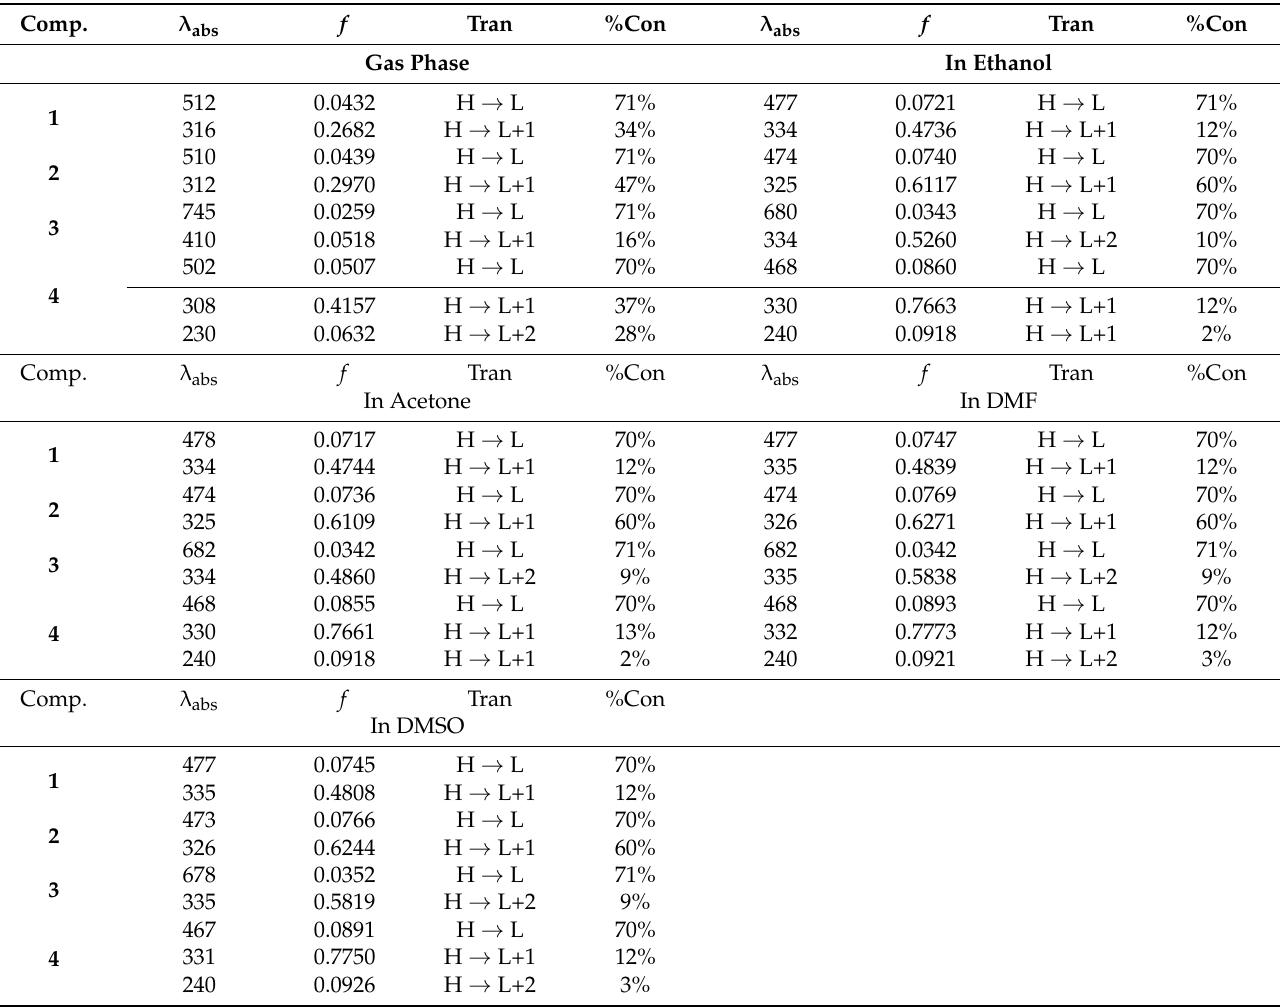
Table 3. The absorption wavelengths ( λ abs , nm), oscillator strengths ( f ), %Contribution (%Con), and main transitions in the gas phase as well as in solvents (ethanol, acetone, DMF, and DMSO) of Schiff base compounds at TD-B3LYP/6-31+G**